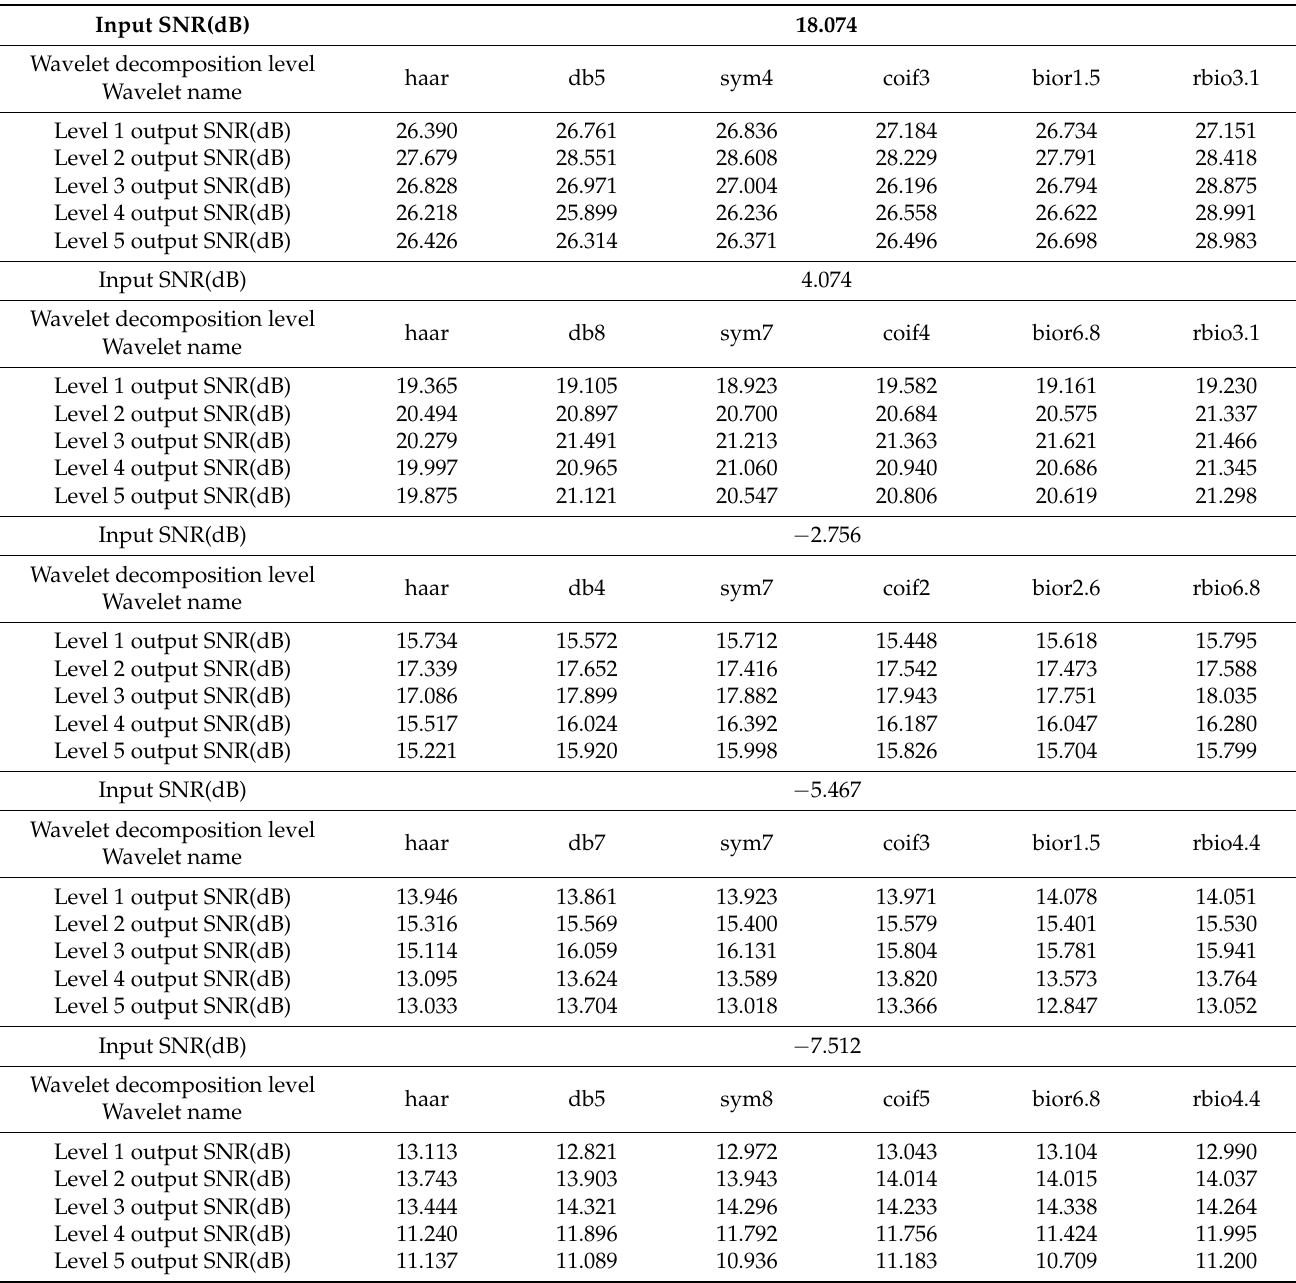
Table 1. DWT-Resnet18 denoising results for seismic data with different noise levels, using different wavelet basis functions, and at different wavelet decomposition